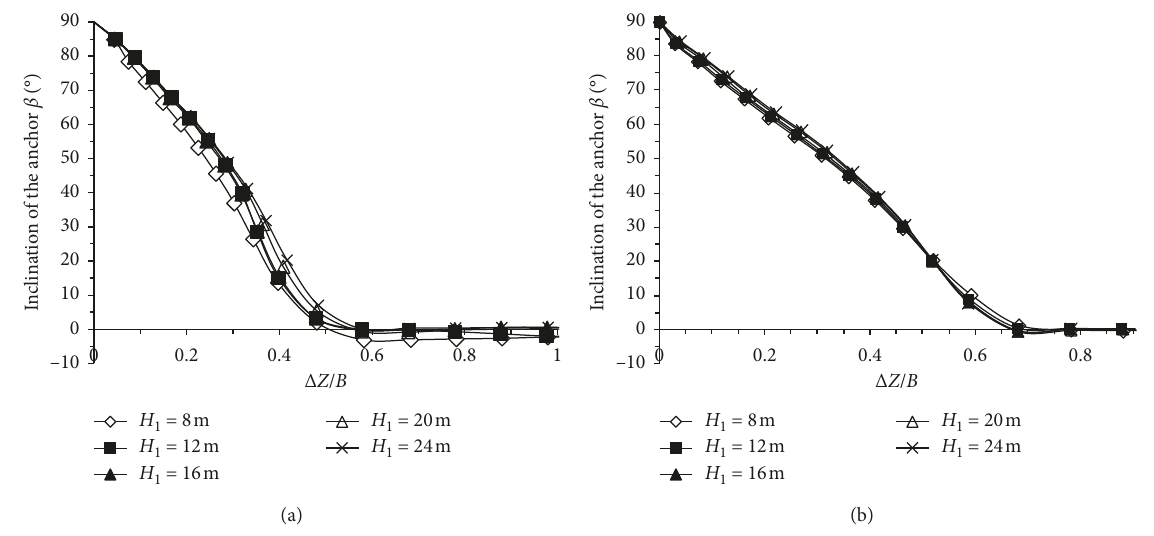
Figure 10: Influence of top soil layer thickness on the plate anchors at position P position P 3